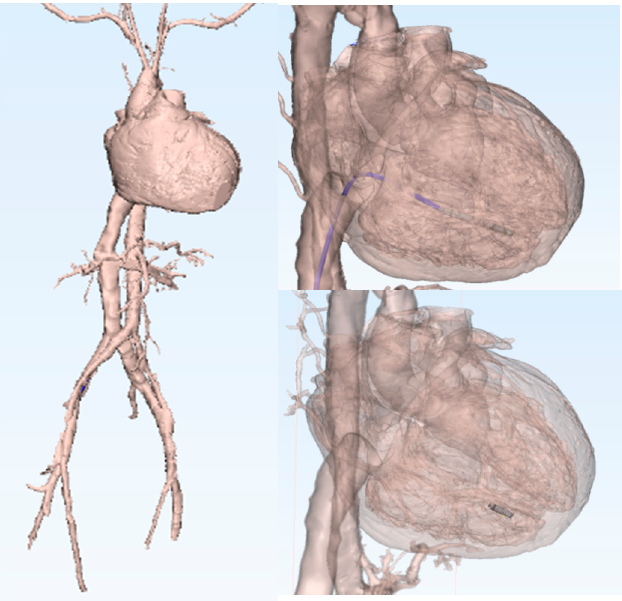
Figure 5. 3D human heart model (HH229) with computationally added vasculature. A Micra TM transcatheter pacing system delivery catheter and a Micra TM were computationally implanted in the right ventricular